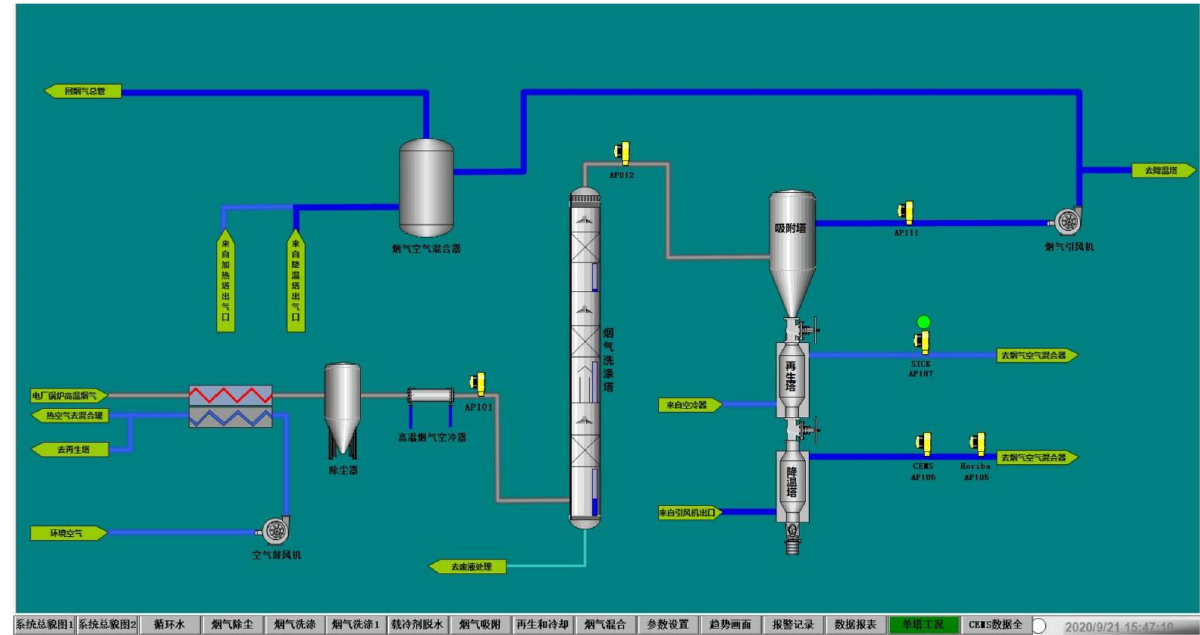
Figure 14. Process diagram of the low-temperature adsorption